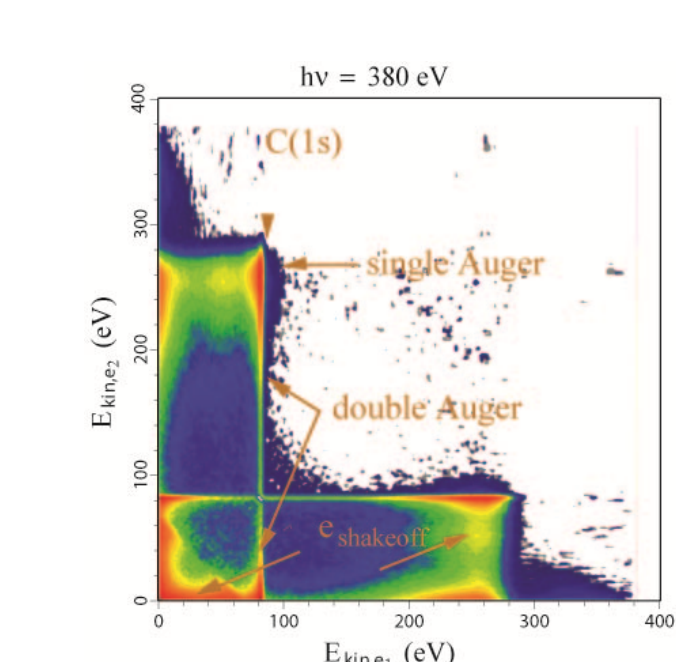
Figure 4 – Electron-electron coincidences as a function of the kinetic energy of the two detected electrons. The coincidence map was recorded with a photon energy of 380